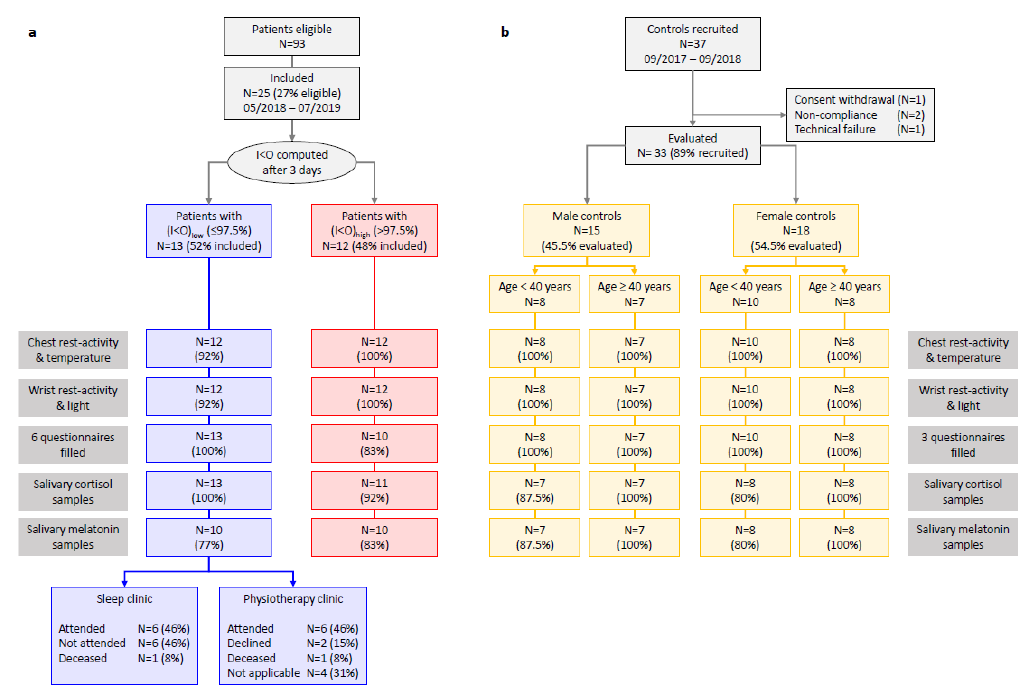
Figure 1. Consort diagram. Flow diagrams of both studies showing the enrollment of subjects and the variables that were measured. ( a ) Cancer patients, as categorized according to the a priori defined threshold of the dichotomy index I < O. Chest rest-activity and temperature not available for one patient due to logistics issues. Wrist rest-activity and light exposure pattern not available for one patient due to patient non-compliance. Chronotype not available for one patient. Cortisol, melatonin, diary and the M.D. Anderson Symptom Inventory (MDASI) questionnaires not provided by one patient. No or insu ffi cient melatonin or cortisol samples for two patients. ( b ) Controls, stratified according to age and sex (parameters reported here are the ones which are common to both studies). Three controls did not provide any salivary samples as they were recruited before inclusion of salivary samples collection to the